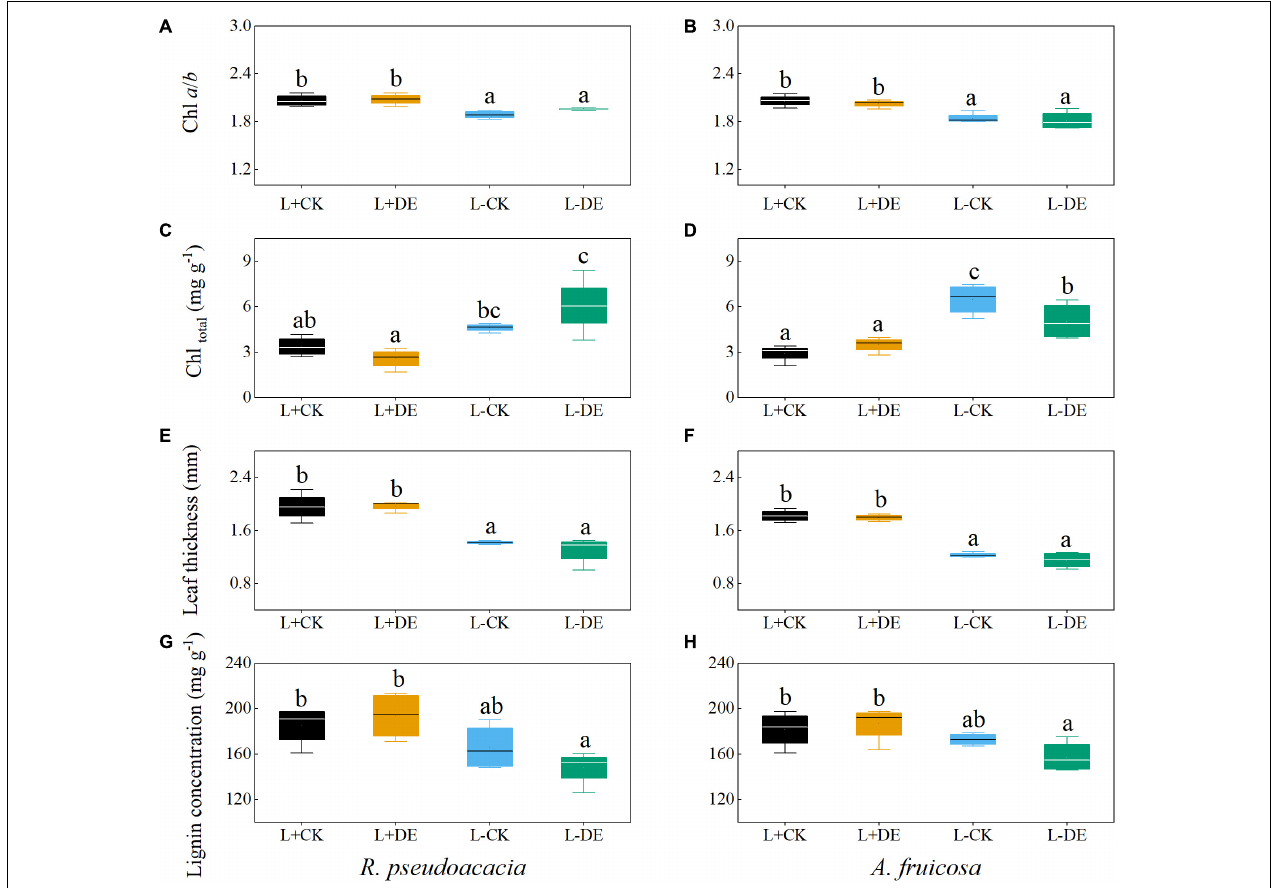
FIGURE 4 | Seedling leaf traits of R. pseudoacacia (A,C,E,G) and A. fruticosa (B,D,F,H) under different light and defoliation treatments for 70 days. The values are shown as mean ± SE ( n = 4). Different letters indicate significant differences among different treatments at each sampling according to Duncan’s test ( p < 0.05). L + CK, high light condition with no defoliation; L + DE, high light condition treatment with defoliation; L − CK, low light condition with no defoliation; L − DE, low light condition with